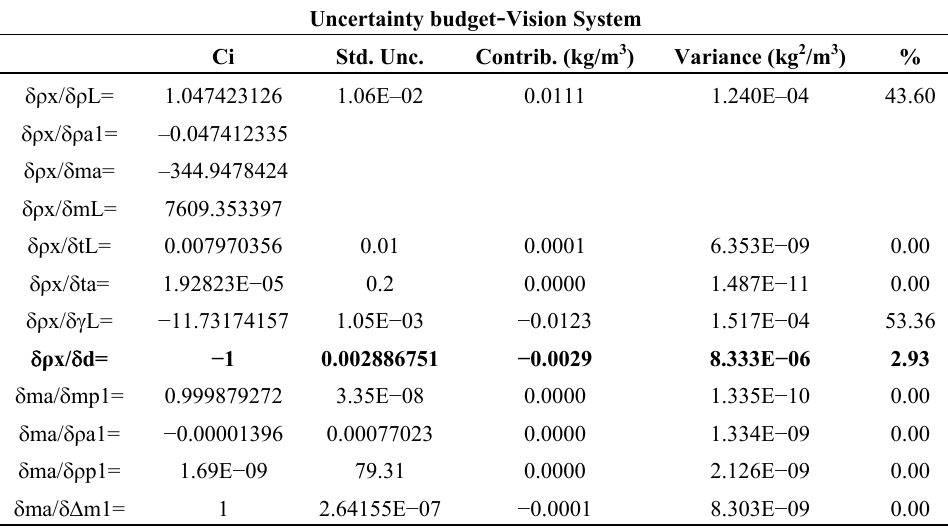
Table 11. Uncertainty budget − Vision System method − d = 0.1 kg/m 3